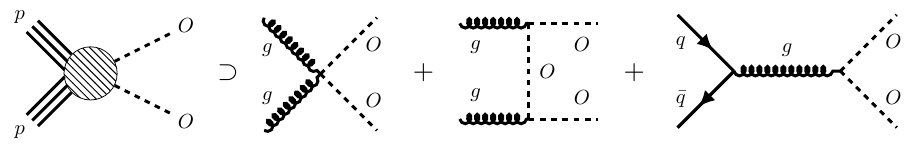
Figure 1 . Representative diagrams for scalar sgluon pair production due to gluon fusion and quark- antiquark annihilation [63]. Diagrams for pseudoscalar pair production are given by replacing O → o everywhere.